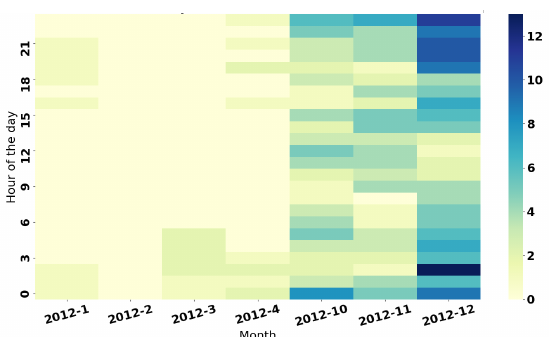
Figure 5. Hourly number of detections of mysticetes by month for the 2011–2012 site A